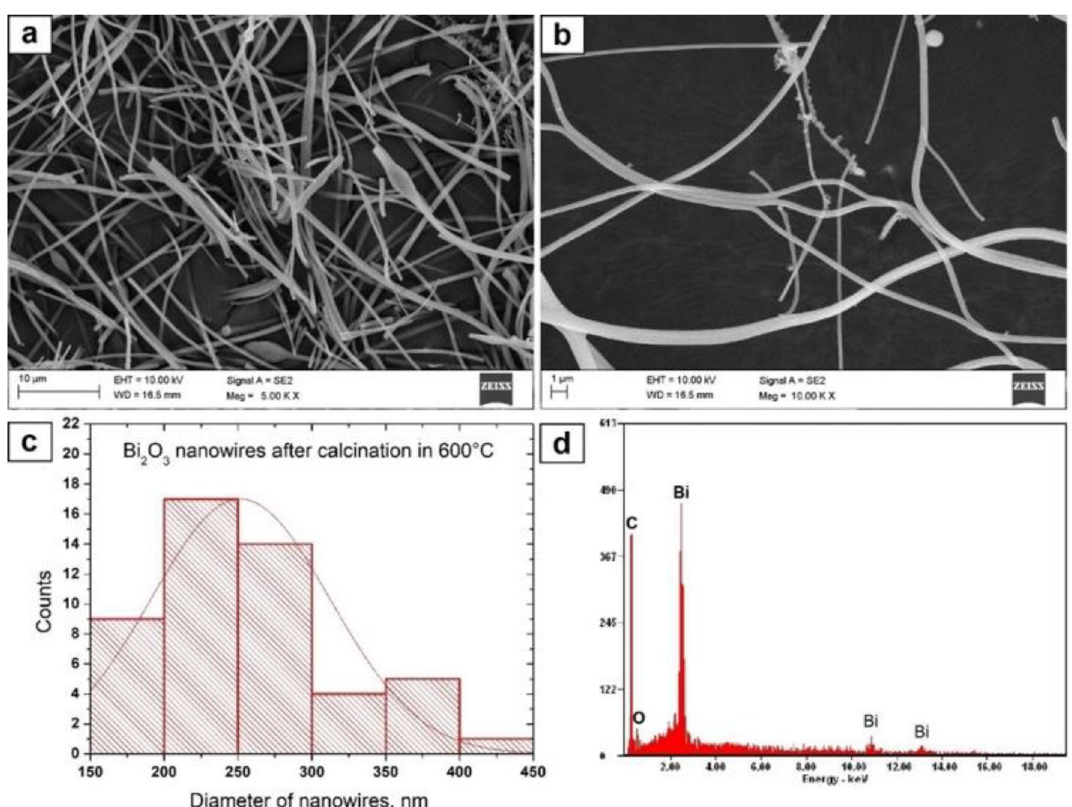
Figure 6. SEM image of the topography on the surface of obtained nanowires after calcination the PAN/ Bi 2 O 3 fibrous composite mats in 600 °C, magnification 5 000 x ( a ) and 10 000 x ( b ), histograms presenting the distribution of the diameter of randomly selected nanowires ( c ), EDS spectra (peak of C derive from the substrate on which nanowires were deposited) from the entire area shown in the SEM images ( d